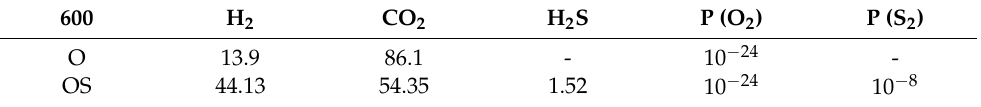
Table 1. Composition of the two gas mixtures (vol.%) and the corresponding equilibrium partial pressures (atm) of sulphur and/or oxygen at 600 ◦ C (Oxidation—O, Oxidation-sulphidation—OS). 600 H 2 CO 2 H 2 S P (O 2 ) P (S 2 ) O 13.9 86.1 - 10 − 24 - OS 44.13 54.35 1.52 10 −